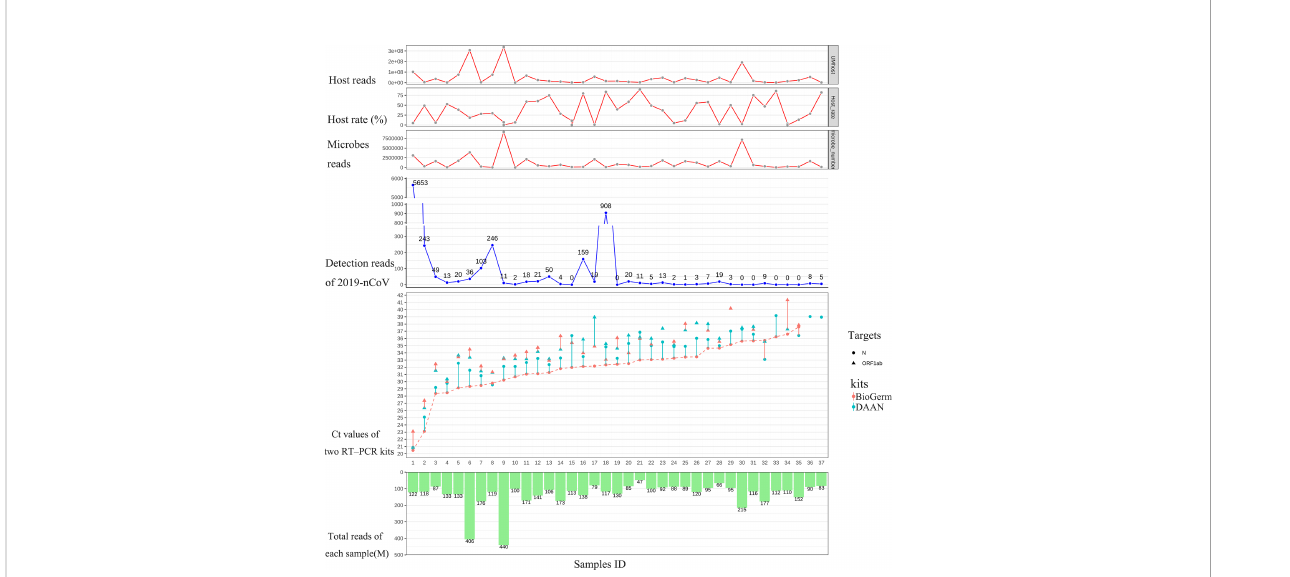
FIGURE 1 Results comparison between mNGS and two approved RT-qPCR methods. From left to right, the 37 samples were sorted according to the Ct value of N gene from DAAN (red curve). From top to bottom are the host reads, the percentage of host read in each sample, microbes read in each sample, detection read number of 2019-nCoV, Ct values of two RT-PCR kits and total reads (including the reads from host and microbes in swab sample) generated from each